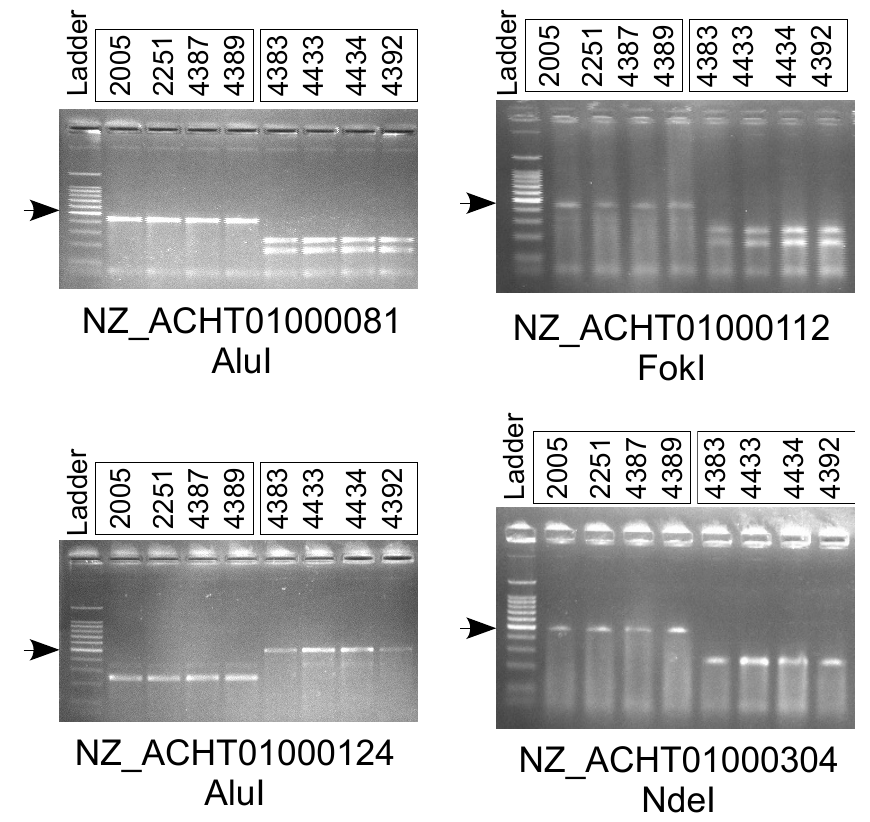
Figure 5. Experimental validation of single-nucleotide polymorphisms (SNPs) between the two sub-lineages of Xanthomonas campestris pathovar musacearum ( Xcm ). We amplified specific sequence fragments of approximately 500 bp flanking single-nucleotide polymorphisms that we had identified from whole-genome sequencing. Polymerase chain reaction (PCR) was performed on genomic DNA from four isolates from sub-lineage I (NCPPB2005, NCPPB2251, NCPPB4387 and NCPPB4389) and from four isolates of sub- lineage II (NCPPB4383, NCPPB4433, NCPPB4434 and NCPPB4392). The sequences of the PCR primers are given in Table 5. We digested each of the PCR products with a restriction enzyme (AluI, EcoRI, FokI, NdeI or RsaI). We ran the digested PCR products on a 2% agarose gel alongside a 100 bp ladder (Promega G210A) in which the brightest band, marked with a black arrow, indicates 500 bp.